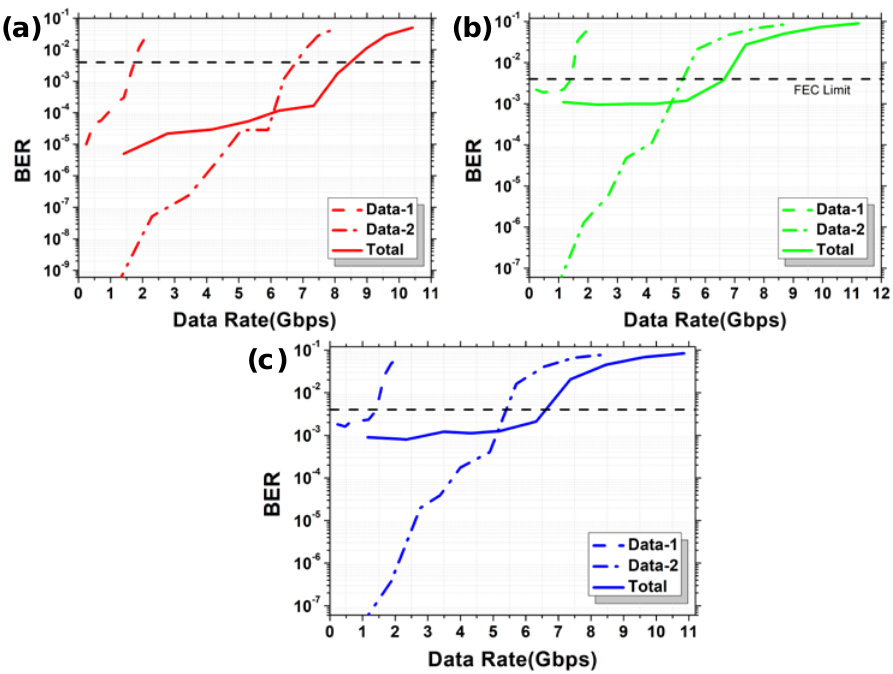
Figure 10. Experimental BER curves of the Data 1, Data 2, and the combined OFDM-NOMA signals for the ( a ) R, ( b ) G, and ( c ) B channels in QPSK format.